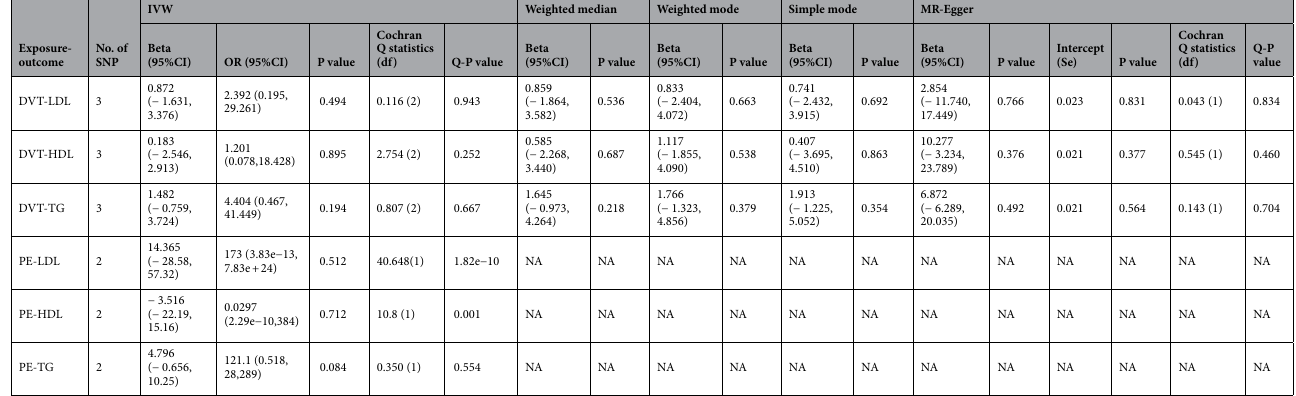
Table 3. MR estimates from different methods of assessing the causal effect of VT on classical lipids. Se standard error, SNP single nucleotide polymorphism, MR Mendelian randomization, IVW inverse variance weighting, VT venous thromboembolism, PE pulmonary embolism, DVT deep venous thrombosis, LDL low density lipoprotein, HDL high-density lipoprotein, TG triglyceride, CI confidence